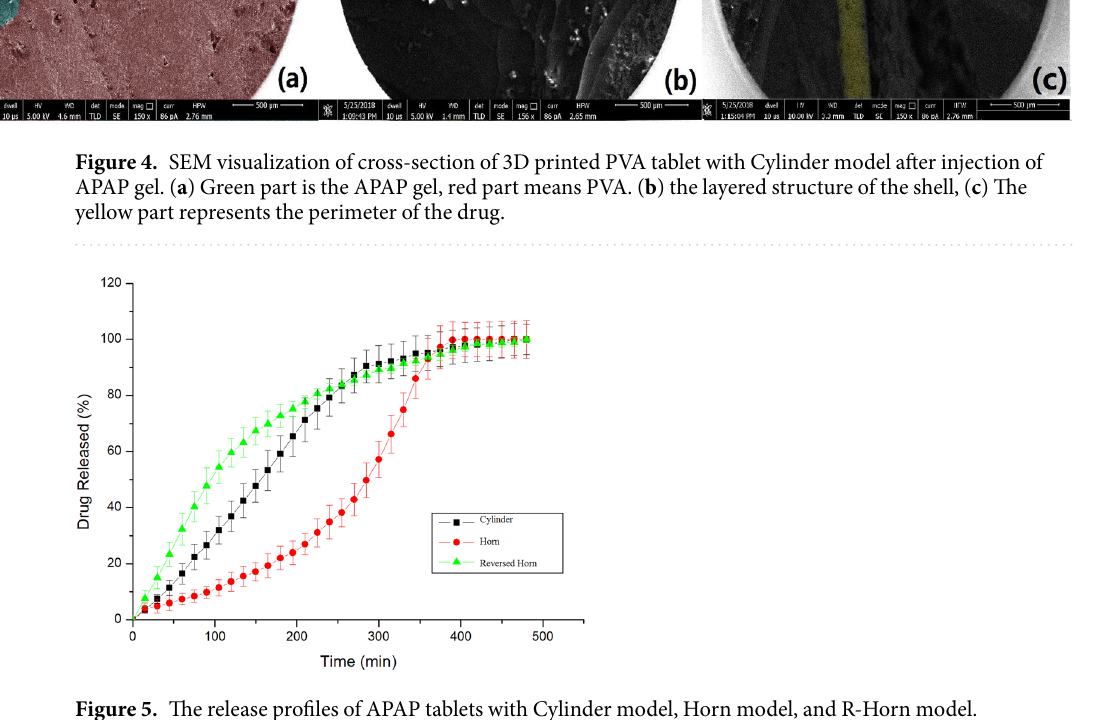
Figure 5. The release profiles of APAP tablets with Cylinder model, Horn model, and R-Horn